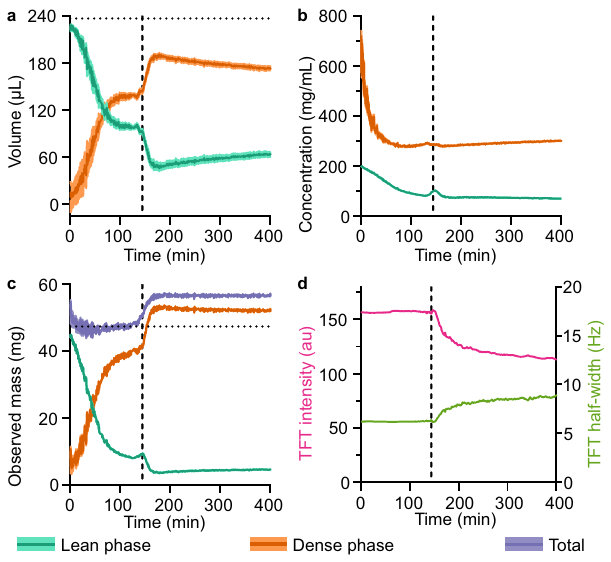
Fig. 5 Kinetics of LLPS and layer separation of BSA at 40 °C characterised by bulk-detection NMR. a Apparent volume of the lean and dense phases. Dotted horizontal line indicates the observed sample volume (236.8 µ L). b Concentration of the lean and dense phases. c Apparent mass of BSA in the NMR-observed sample volume. Dotted horizontal line indicates the expected total mass in the observed volume in the absence of any layer separation (47.36 mg). d TFT reference peak intensity (pink, left axis) and half-width (green, right axis). For all panels, line plots are the calculated values, while the shaded regions represent parameter error estimates following propagation of 95% con fi dence intervals in MATLAB fi tting. Dashed vertical line at 140 min on all plots indicates the onset of layer separation accompanied by decrease in local magnetic fi eld homogeneity. Source data are provided as a Source Data fi le.